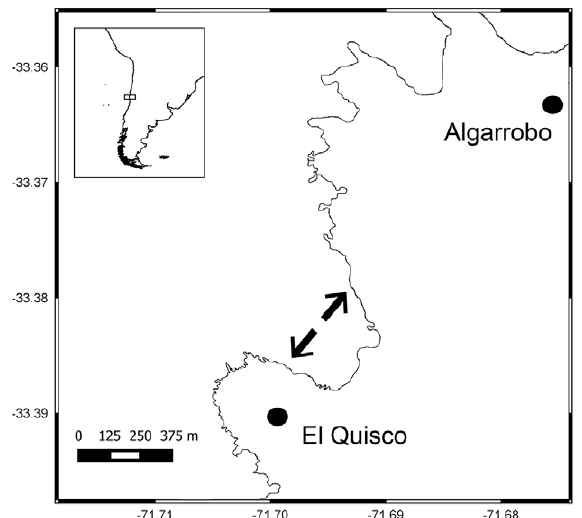
Fig 1. – Map of the study area off El Quisco Bay, central Chile, southeast